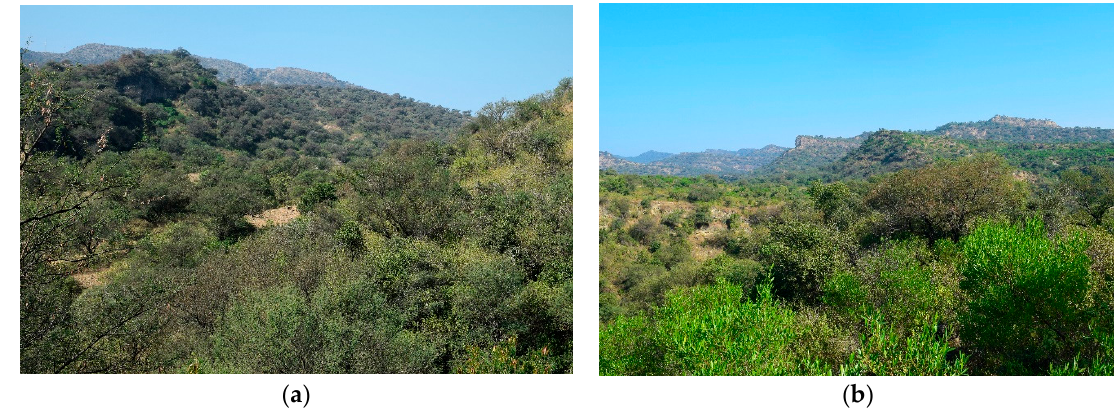
Figure 2. Topography of the study area showing dry scrub forest vegetation with stands of A. modesta and L. camara ( a ) and D. viscosa ( b ) in the district Jhelum, Punjab,